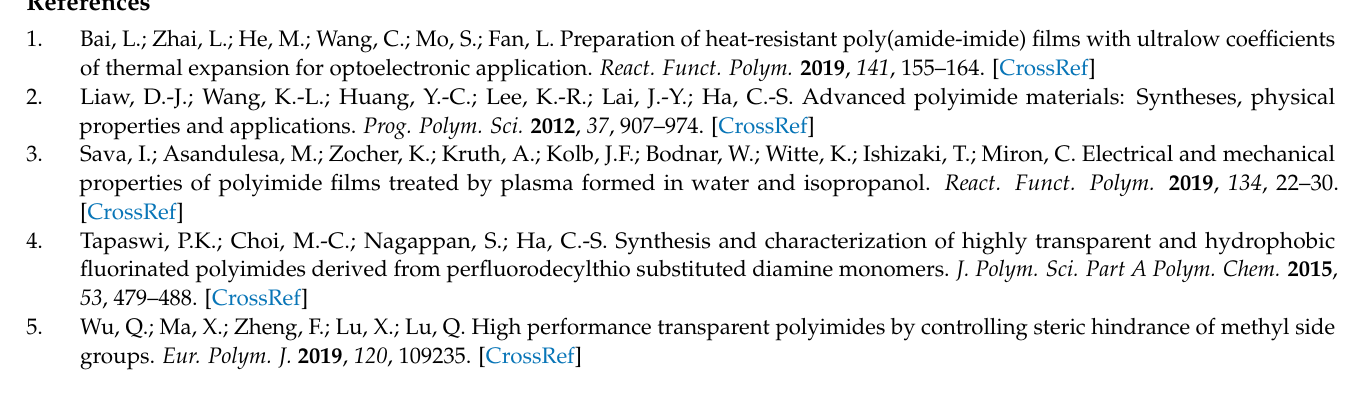
2 ; Figure S2: The 13 C NMR spectrum of compound 2 ; Figure S3: The 19 F NMR spectrum of compound 2 ; Figure S4: The 1 H NMR spectrum of compound 3 ; Figure S5: The 13 C NMR spectrum of compound 3 ; Figure S6: The 19 F NMR spectrum of compound 3 ; Figure S7: The 1 H NMR spectrum of compound 4 ; Figure S8: The 13 C NMR spectrum of compound 4 ; Figure S9: The 19 F NMR spectrum of compound 4 ; Figure S10: The 1 H NMR spectrum of compound 5 ; Figure S11: The 13 C NMR spectrum of compound 5 ; Figure S12: The 19 F NMR spectrum of compound 5 ; Figure S13: The 1 H NMR spectrum of compound 6 (3FPODA); Figure S14: The 13 C NMR spectrum of compound 6 (3FPODA); Figure S15: The 19 F NMR spectrum of compound 6 (3FPODA); Figure S16: ( a ) FT-IR spectra of compound 2 ; ( b ) FT-IR spectra of compound 3 ; ( c ) FT-IR spectra of compound 4 ; ( d ) FT-IR spectra of compound 5 ; ( e ) FT-IR spectra of compound 6 ; Table S1: The solubility properties of